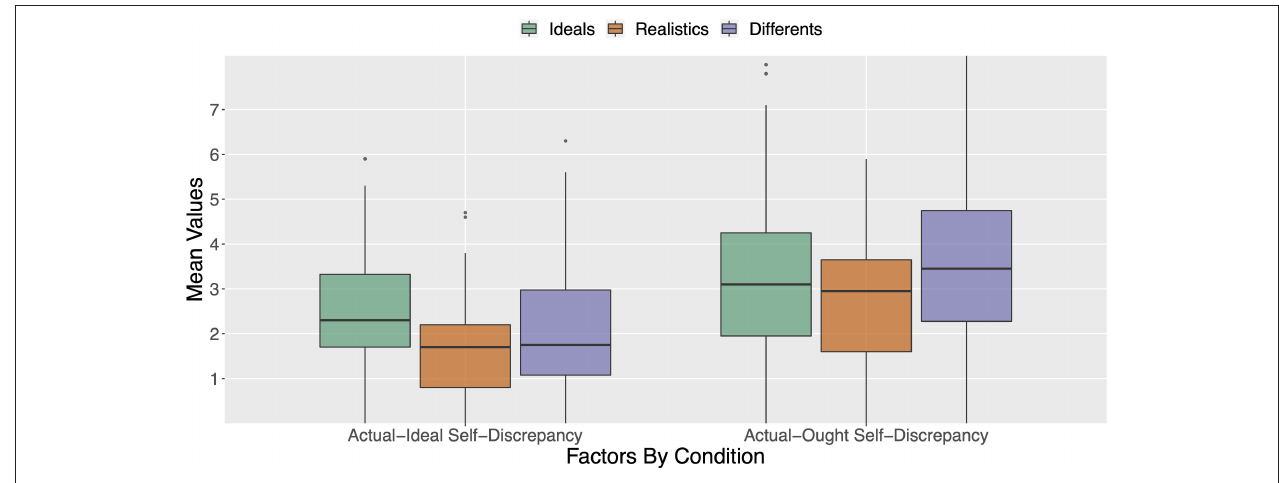
FIGURE 1 | Comparison of Realistics, Ideals, and Differents for their actual-ideal and actual-ought self-discrepancy